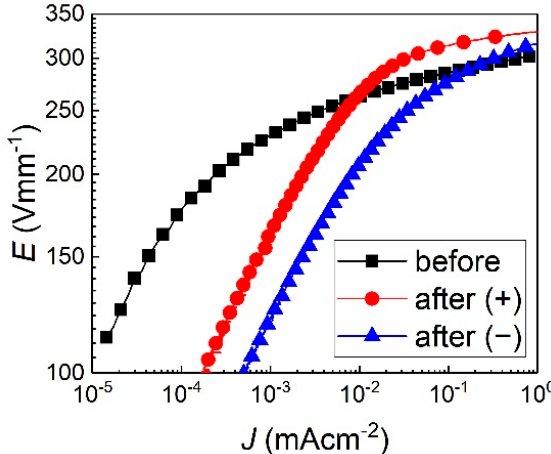
Figure 2. J - E characteristics of S1 before and after DC aging.